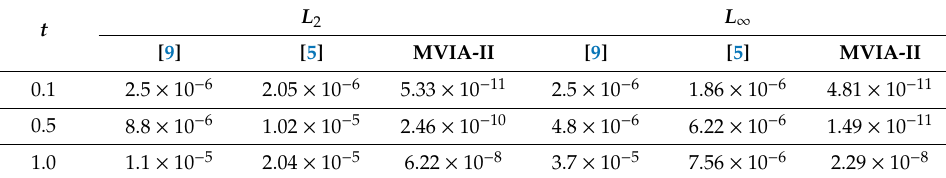
Table 6. Comparison of L 2 and L ∞ error norms for di ff erent values of t for Test Problem 3.